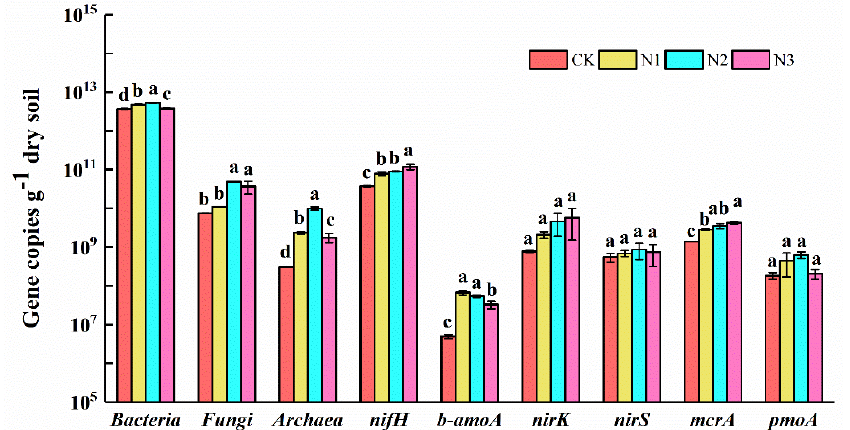
Figure 1. The effect of nitrogen addition on soil microbial functional gene abundance in per- N3: 24 g N · m − 2 · year − 1 . Different letters indicate a significant difference among different concentra- tions of nitrogen addition treatments ( p < 0.05) as estimated by one-way ANOVA and a post hoc Duncan’s multiple-range